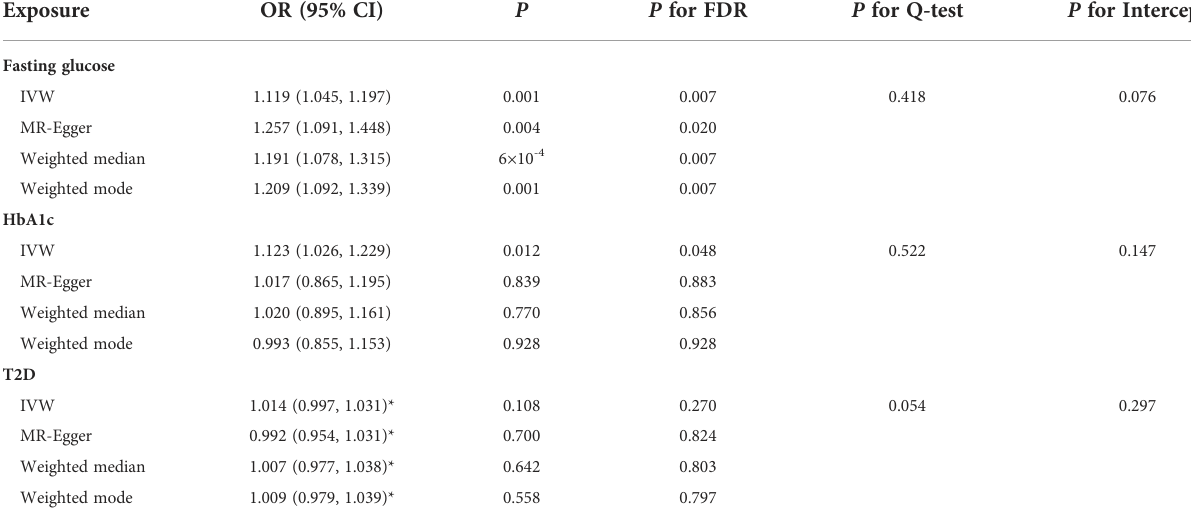
TABLE 1 Summary statistics for MR analyses of the potential causal effect of glycemic traits on periodontitis. Exposure P P for FDR P for